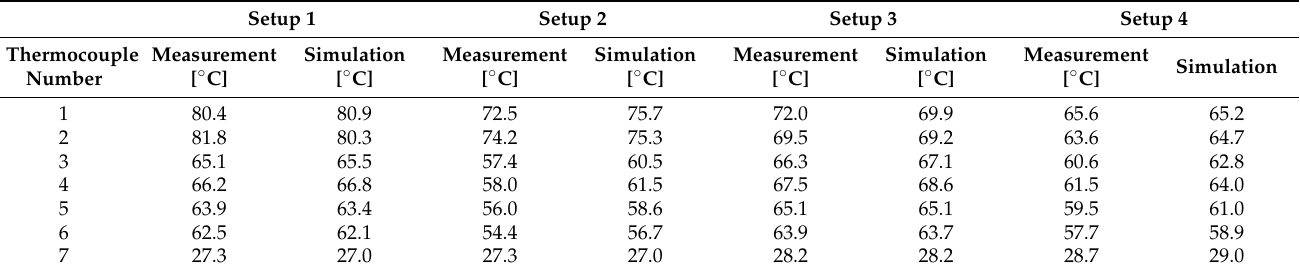
Table 5. Temperature results overview: measurements and